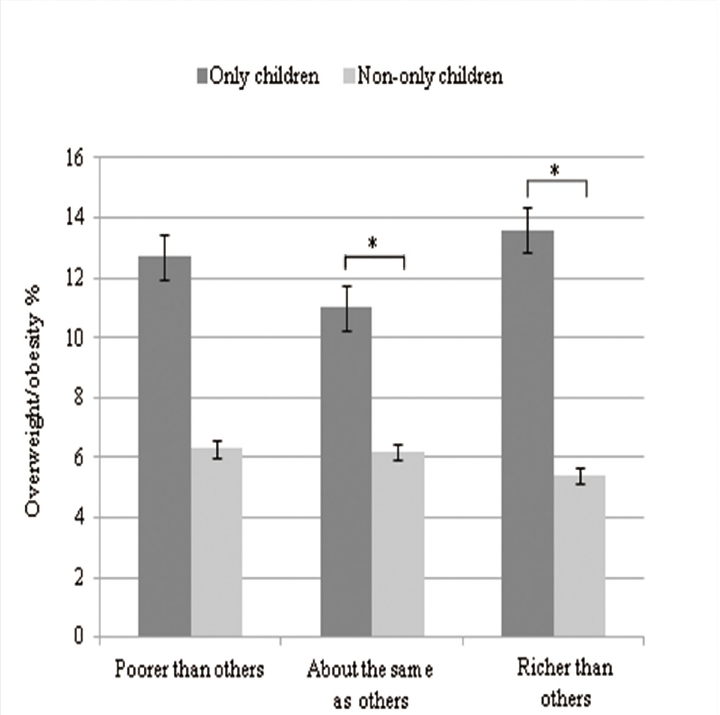
Fig 2. Association between familial socioeconomic status and prevalence of overweight/obesity among groups with low (n = 123), mid-level (n = 786) and high socio-economic status (n = 313), stratified by existence of siblings.